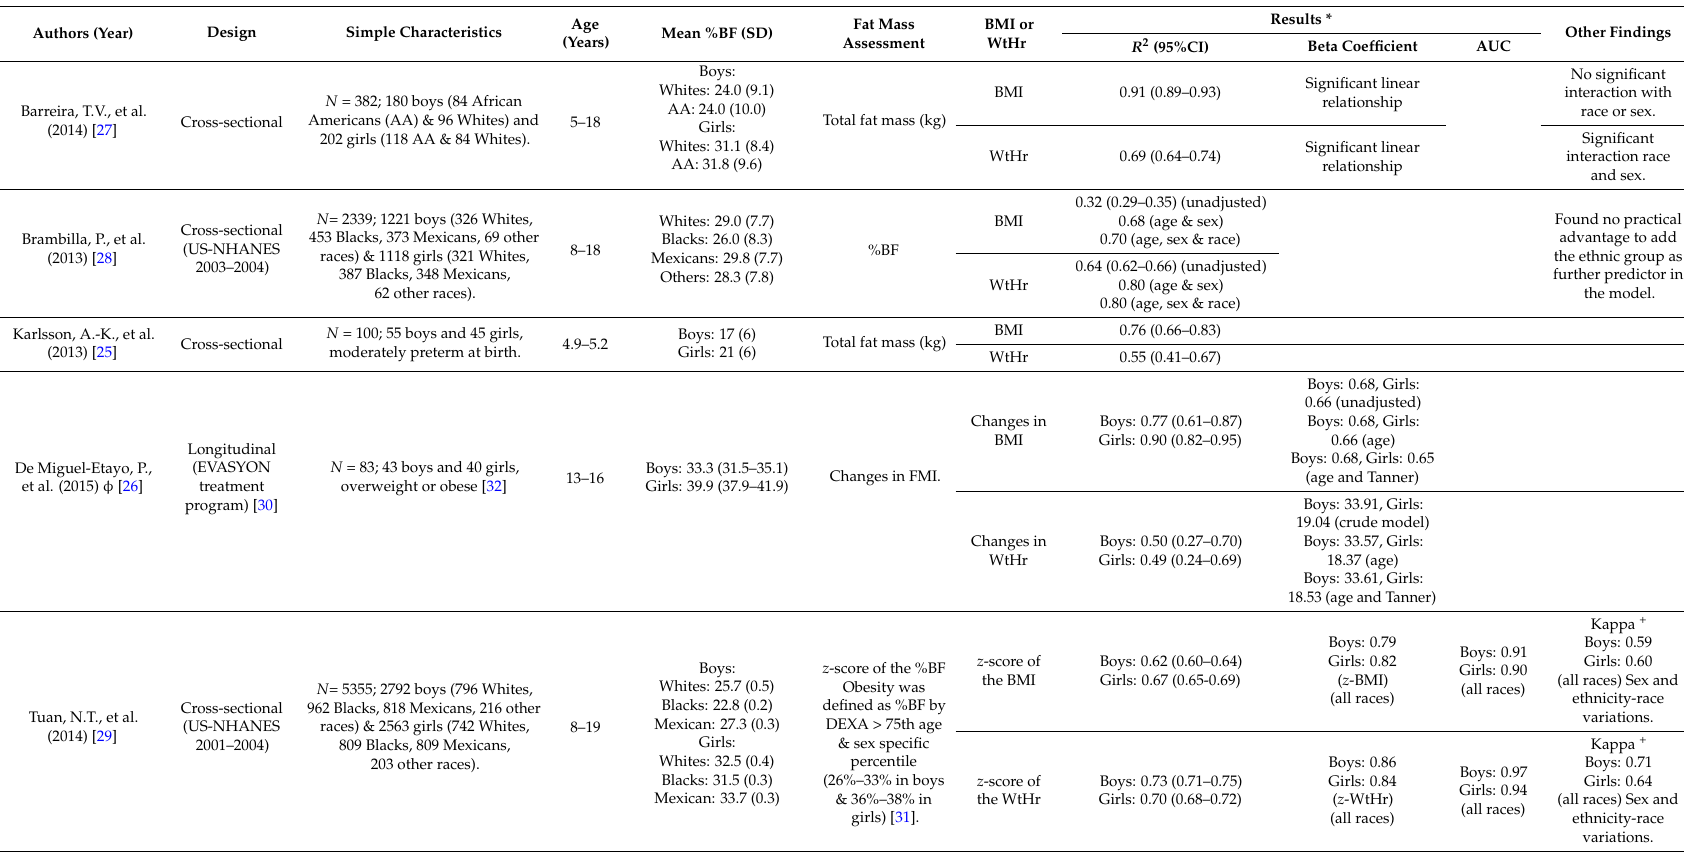
Table 1. Characteristics of the five studies that assessed the correlation of both body mass index (BMI) and waist-to-height ratio (WtHr) with body fat (BF) measured by dual-energy X-ray absorptiometry (DEXA).